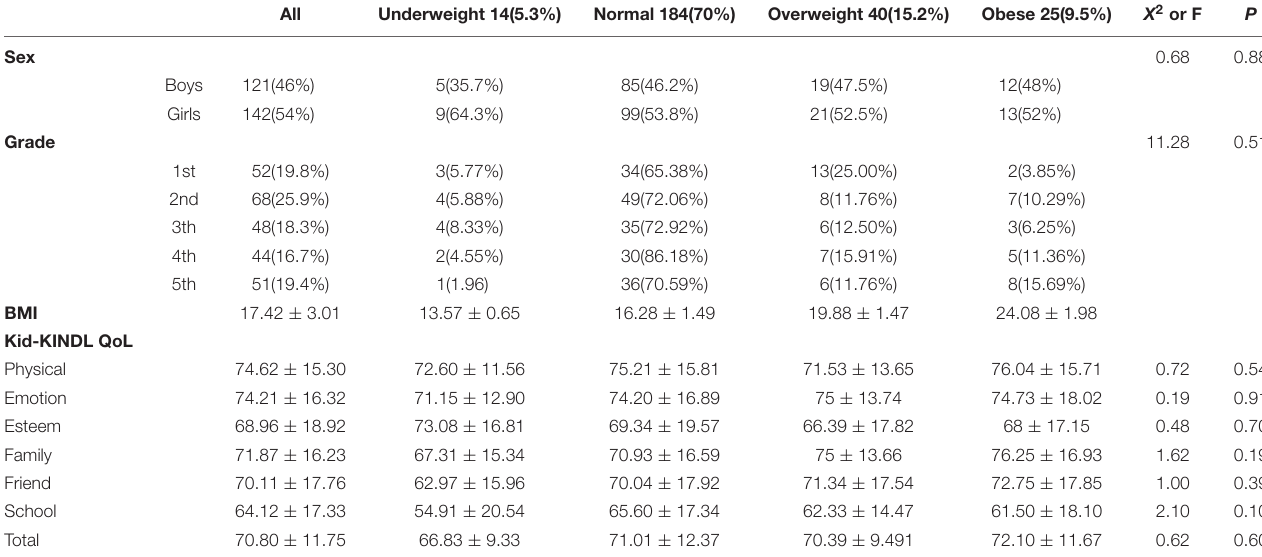
TABLE 1 | Descriptive statistics for participants’ background characteristics and Kid-KINDL Quality of Life across different BMI ranges. All Underweight 14(5.3%) Normal 184(70%) Overweight 40(15.2%)